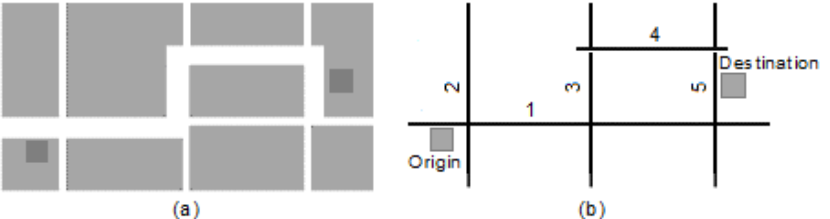
Figure 1. Development of axial lines. (a) Roadway structure; land-use and building blocks are shaded. (b) Axial